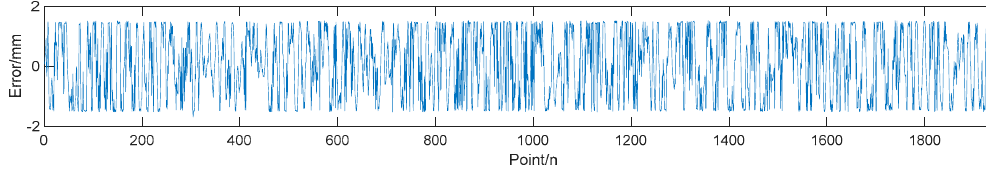
Figure 8. The EMD-SVR predict error.